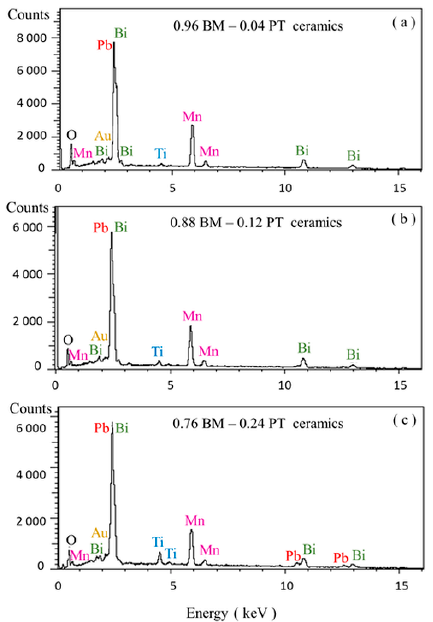
Figure 7. The survey spectra obtained for: ( a ) 0.96 BM–0.04 PT, ( b ) 0.88 BM–0.12 PT, and ( c ) 0.76 BM–0.24 PT ceramics. Table 1. Exemplar atomic concentration (at%) estimated for chosen ceramics surfaces.